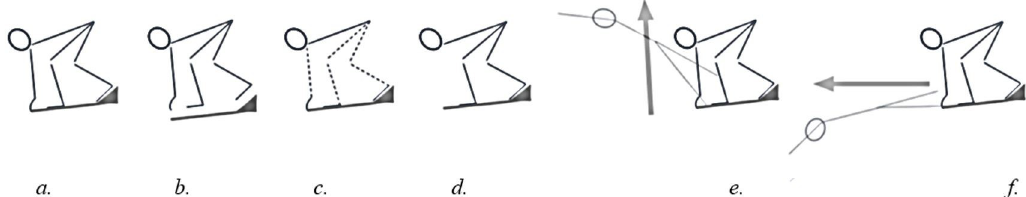
Fig 1. Visual representation and explanation of the six different start conditions. The start conditions were labelled as (a) ‘regular’, (b) ‘block time as short as possible’, where block time was defined as the ‘time from the start signal until take-off (i.e. the last instant at which the swimmer is in contact with the block)’, (c) ‘block phase at submaximal effort’, i.e. participants were instructed to perform maximally only from the moment they entered the water, (d) ‘block phase without using arms’, (e) steep take-off, and (f) flat take-off. Since the take-off angle was defined as the angle between the line from toe to hip and the horizontal at take-off, a steep take-off and a flat take-off correspond to a large and small (positive) take-off angle, respectively.